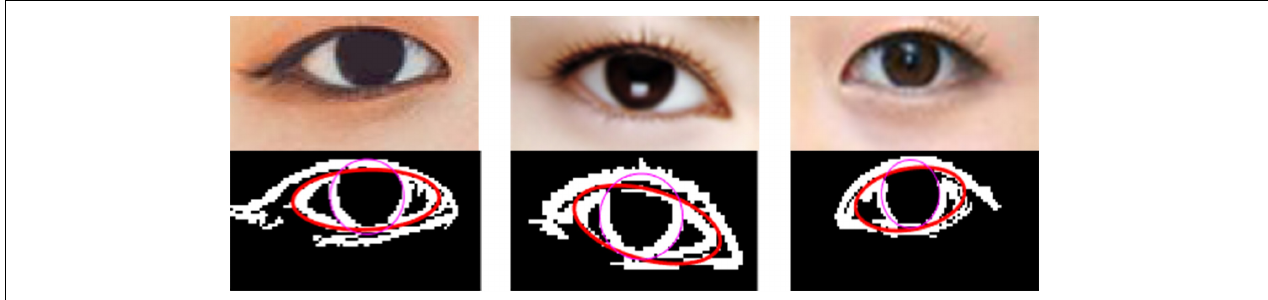
FIGURE 7 | The fitting results of eyes and